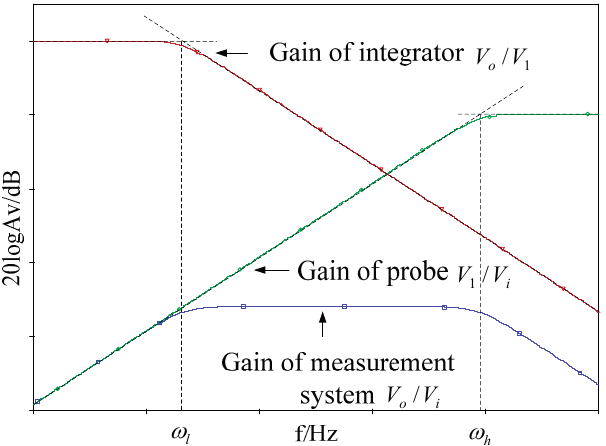
Figure 3. Bode plot of the traditional D-dot